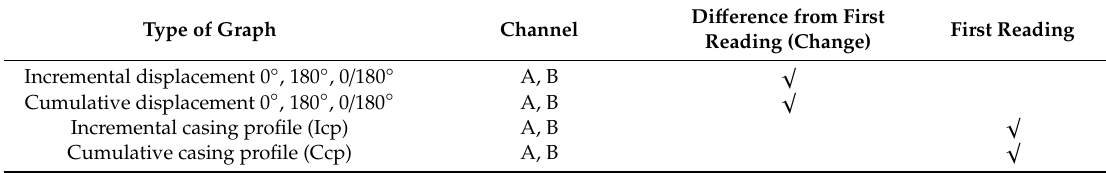
Table 3. Type of graphs plotted for each